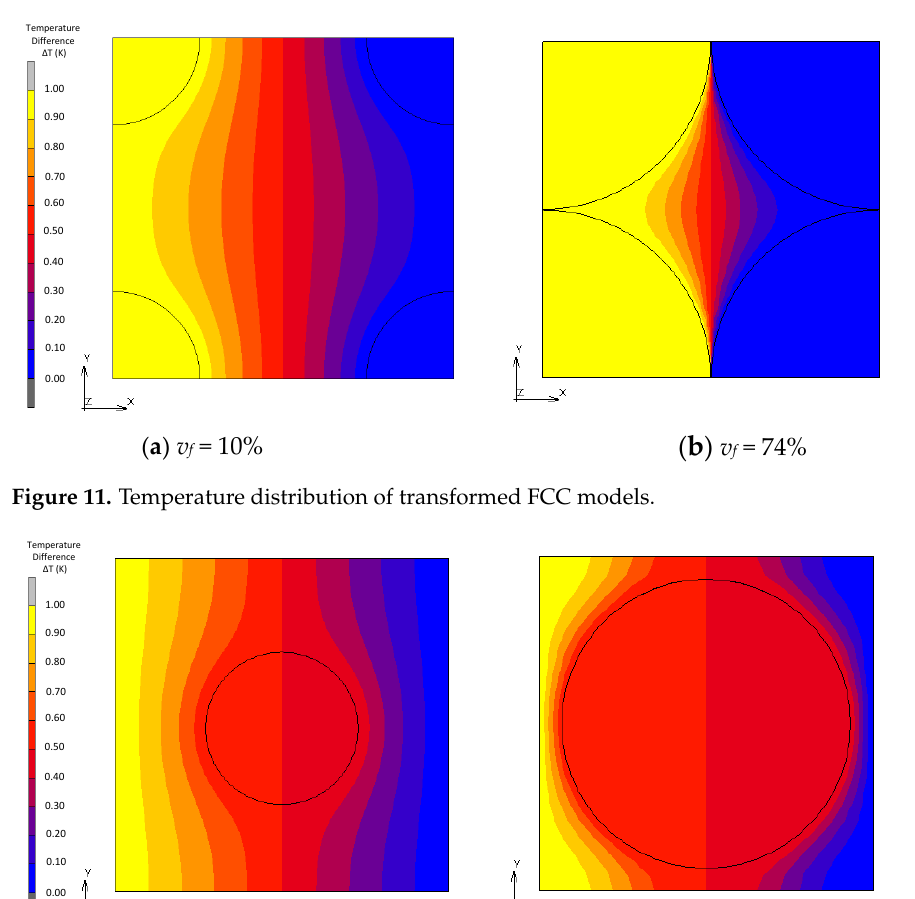
Figure 10. Temperature distribution of FCC models.